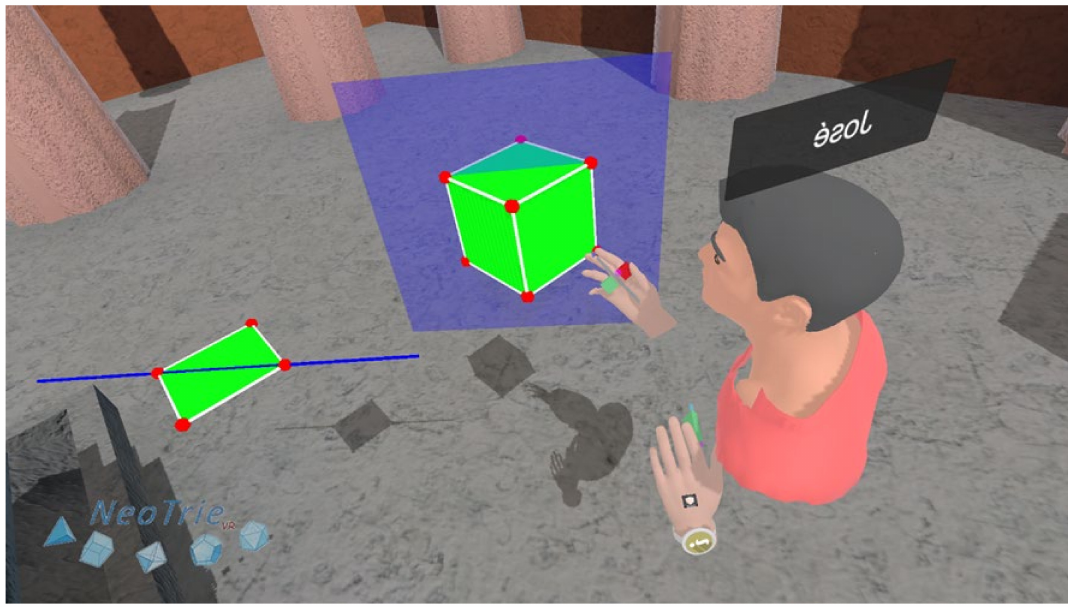
Figure 14. Example of analogy in the comparison of the flat and three-dimensional